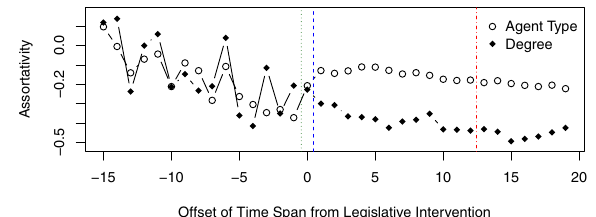
Fig. 7 Assortativity by agent type and degree. Temporal representation of assortativity by agent type (circles) and degree (diamonds) for 30-day spans. Nominal assortativity on agent type illustrates that agents connect to other agents of various types, with a tendency for users to be connected to companies and macro-agents. Degree assortativity shows that early on there was no clear preference of attachment by degree, but then assortativity becomes negative as low-degree nodes, users, prefer to attach to high-degree nodes such as companies and macro-agents.